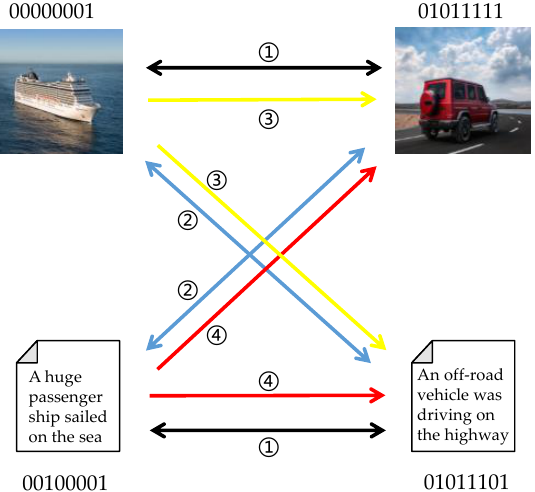
Figure 3. The pair-wise similarity preserving constraint. The anchor is located at the arrow tail. Correspondingly, the samples located at the arrow heads should have the same Hamming distance to the anchor.